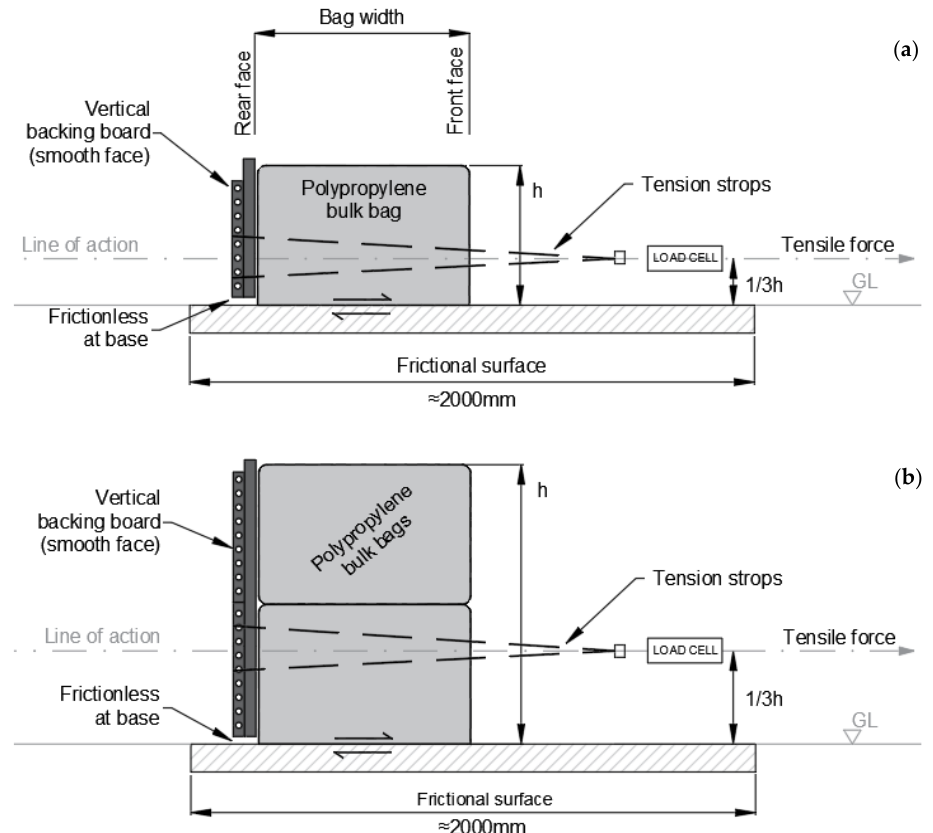
Figure 5. Illustration of field test set-up: ( a ) single bag unstacked; ( b ) double bag stacked. Tension straps were slung around the bulk bag(s). A frictionless backing board uni-